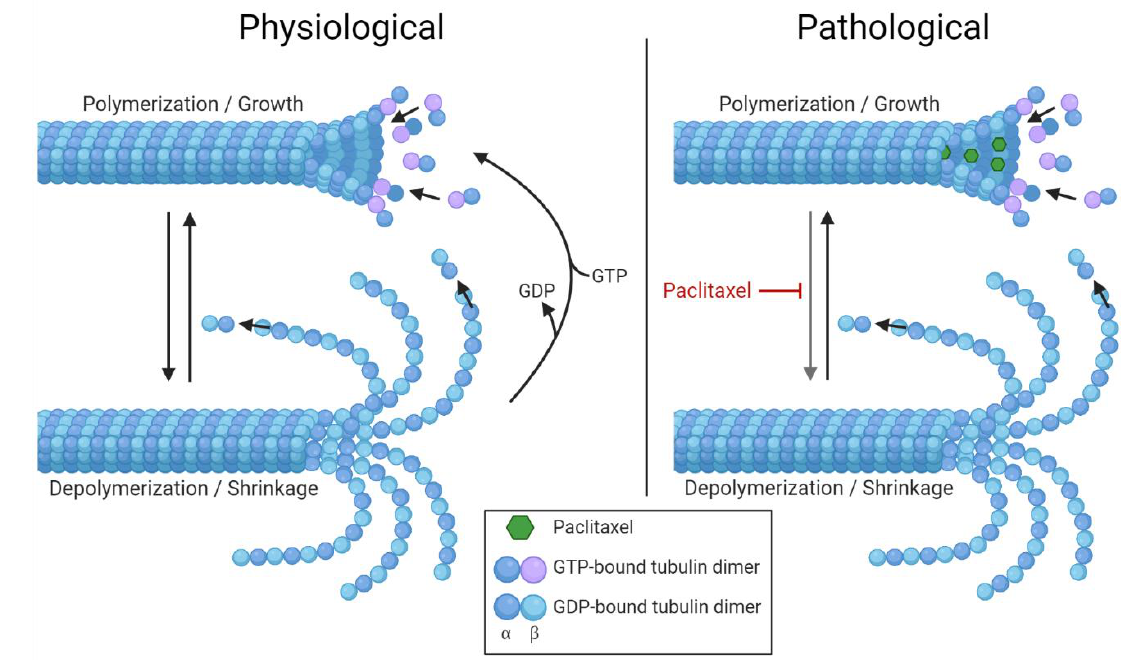
Figure 1. Paclitaxel enhances microtubule stability. Under physiological conditions, guanosine triphosphate (GTP)-bound tubulin dimers get incorporated at the growing end of the microtubules. This structure is supposed to form a stabilizing cap of GTP-bound tubulin. The conformation change in tubulin dimers is due to the GTP getting hydrolyzed into guanosine diphosphate (GDP), and this destabilizes the microtubule lattice. Through the loss of the GTP-tubulin cap, the microtubules are getting depolymerized. This process of microtubule depolymerization gets prevented by paclitaxel binding to β -tubulin (pathological condition). Created with BioRender.com (accessed on 20 September 2021).